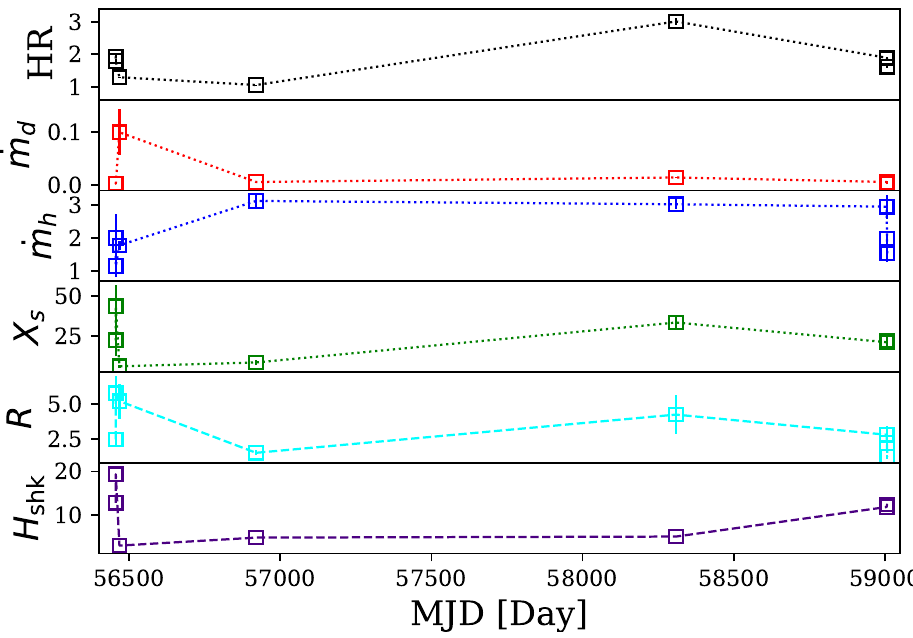
Figure 4. Two-component advective flow (TCAF) model fitted parameter evolutions with observation days are shown along with hardness ratio (HR) estimated from the power-law (PL) model fitted